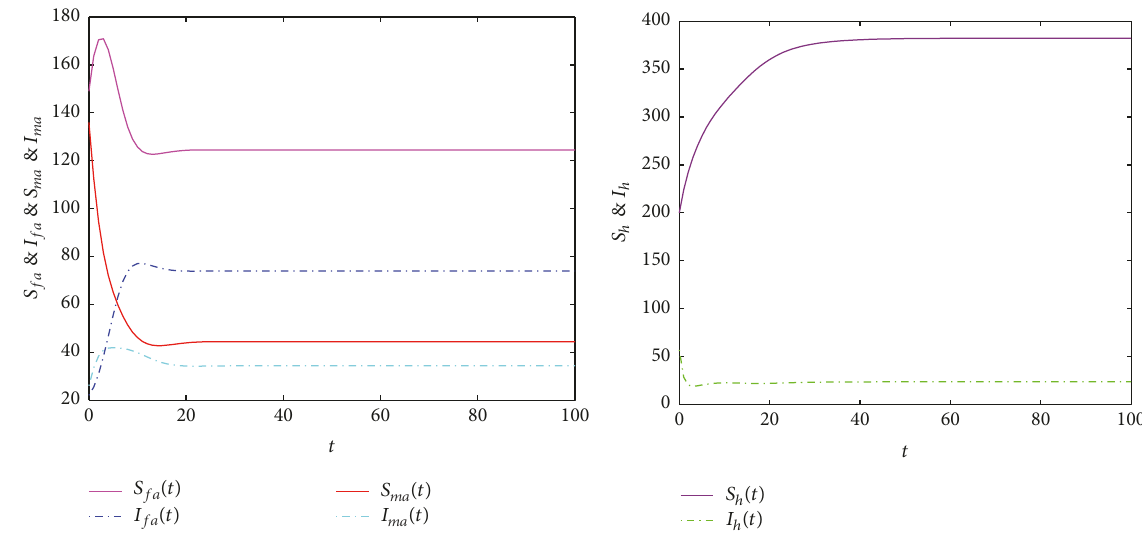
Figure 4: If 𝑅 01 = 2.07373271 > 1 and 𝑅 02 = 1.83929618 > 1 , the time-variation diagram of system (25) state variables is shown.